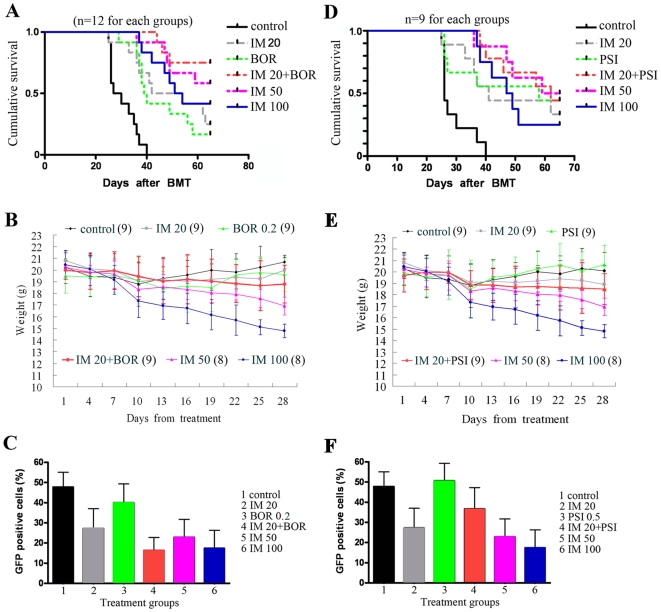
Therapeutic efficacies of IM/BOR and IM/PSI on lethally irradiated BALB/c mice inoculated with BCR-ABL/GFP-expressing murine hematopoietic cells.IM is given daily until death at doses indicated, while BOR (0.2 mg/kg) and PSI (0.5 mg/kg) are intraperitoneally administered twice a week for 4 weeks. (A): Kaplan–Meier estimates of cumulative survival of mice treated with protocols indicated. The results show that IM/BOR significantly prolongs life span of CML mice. In the experiment n = 12 for each group. (B): All mice were weighed throughout the course of the experiment. The graph shows the changes in body weight for mice treated protocols indicated. (C): The percentage of GFP+ cells in peripheral blood is analyzed by flow cytometry. (D): Kaplan–Meier estimates of cumulative survival of mice treated with IM and/or PSI at indicated doses. (E): IM/PSI does not cause weight loss of BALB/c mice. (F), IM/PSI does not significantly reduce GFP+ cells in peripheral blood.